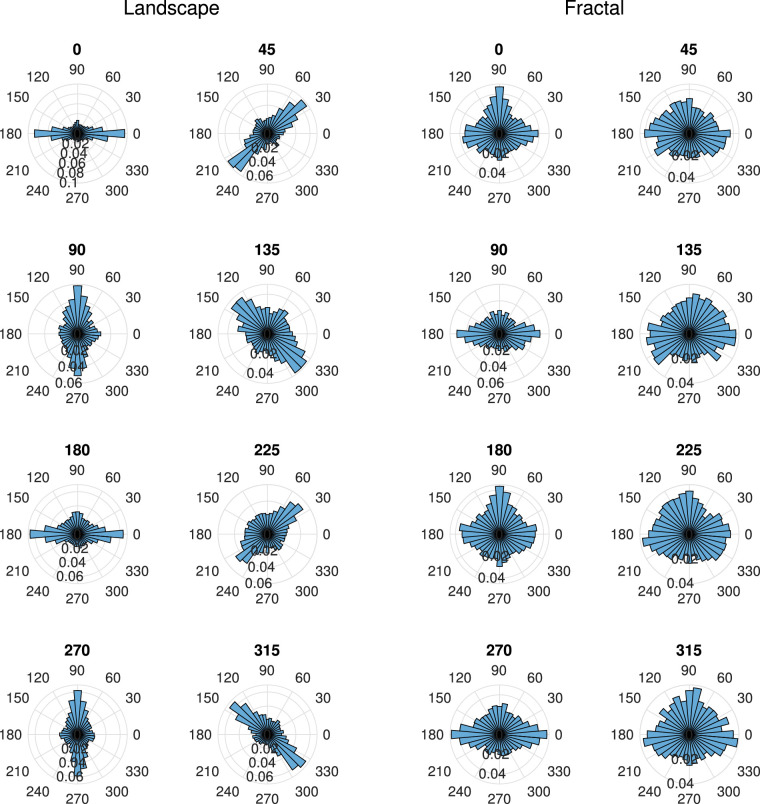
Polar histogram of saccade directions in world coordinates, for the landscape scenes (left), and for the fractal scenes (right), for all scene rotations. The histograms indicate relative probabilities and use a bin size of 10°, and the spacing of the inner rings corresponding a probability difference of 0.02.